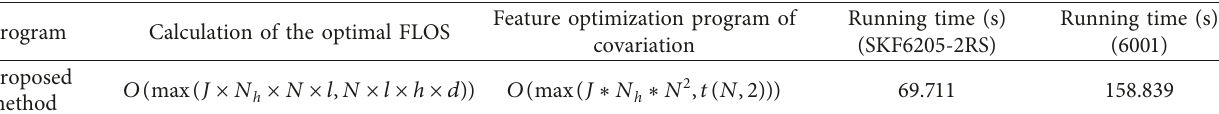
Table 7: Computational complexity of programs in this